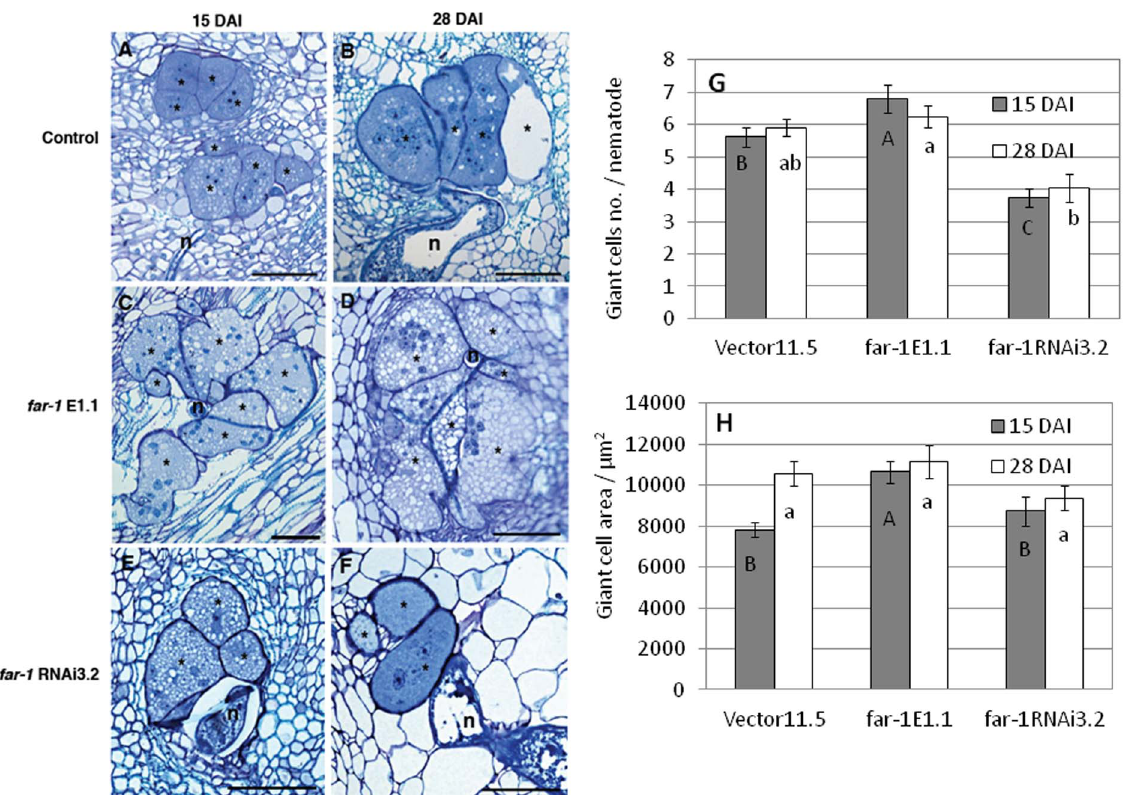
Figure 5. Longitudinal sections of M.javanica feeding sites in inoculated transgenic roots. Histological analysis of roots expressing mj-far - 1 ( C, D ) and mj-far-1 RNAi roots ( E, F ) compared with vector control ( A, B ) were conducted at 15 and 28 DAI. At 15DAI giant cell systems were more developed and consists of more giant cells in roots where an excess of Mj-FAR-1 ( G, H ). Sections were stained with toluidine blue. * giant cell; n, nematode; Bar=100 m m. The average of giant cell number at 15 and 28 DAI of 60 gall cross sections for each tomato hairy root line is presented (G). Giant cell area was measured on 50 giant cells. Measurements are represented by a mean 6 standard error. Statistically significant differences ( P # 0.05, analysis of variance) were determined by Tukey-Kramer multiple comparison tests. Different letters above the bars denote a significant difference.